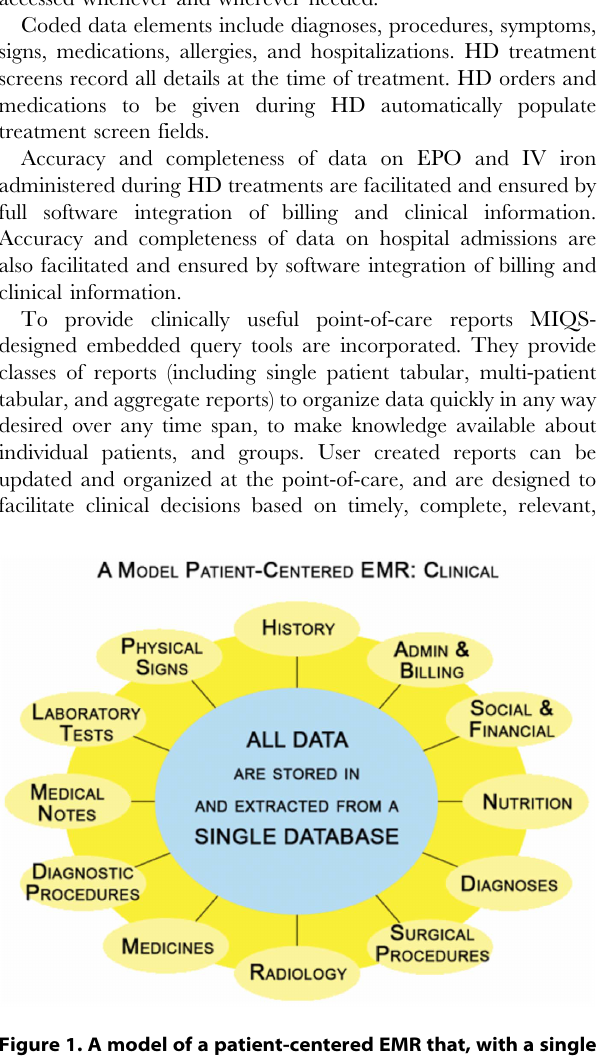
Figure 1. A model of a patient-centered EMR that, with a single database, accommodates multiple clinical functions